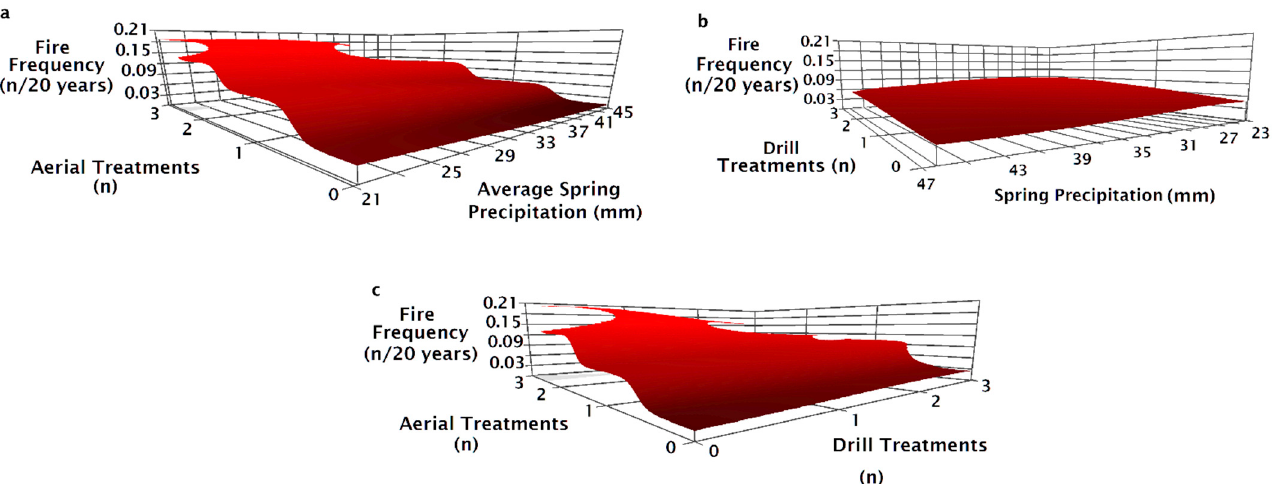
Figure 7. The Nonparametric Multiplicative Regression modeled relationship response of fire frequency to ( a ) the 30-year average spring precipitation and the number of aerial seeding treatments, ( b ) the 30-year average spring precipitation and the number of drill treatments, and ( c ) the number of drill seeding and the number of aerial seeding treatments. The color scale ranges from less frequent fires (black) to more frequent fires (gray). Unshaded areas in the predictor space represent areas where predictor variable data was insufficient to model the relationship.